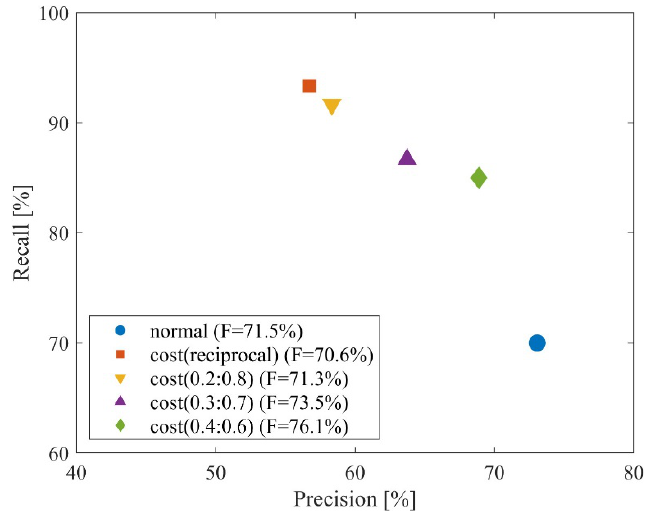
Figure 5. Relationship between precision and recall.